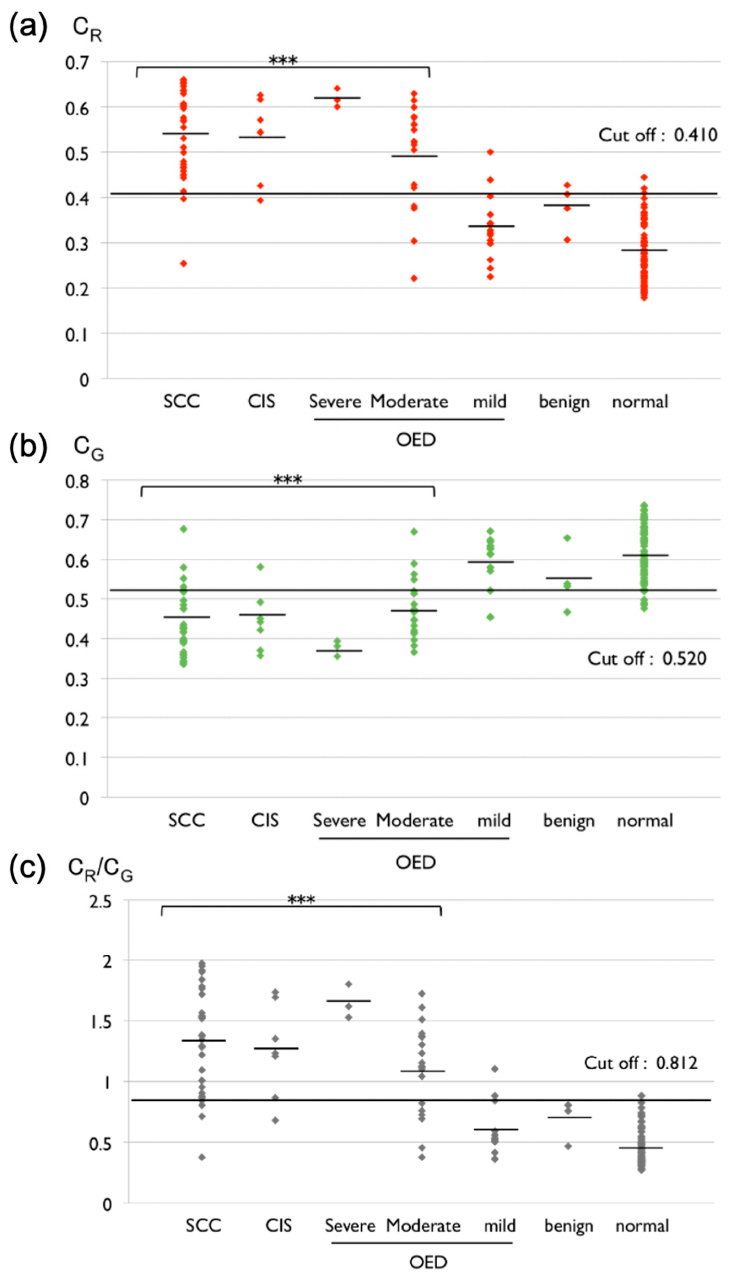
Figure 4. Scatter plots of the C R and C G and C R to C G ratio for different stages of oral lesions. ( a ) C R : chromaticity x (red). The cutoff value (0.410) indicates the borderline between OSCC, CIS, severe or moderate OED, and mild OED or benign lesions. ( b ) C G : chromaticity y (green). The cutoff value (0.520) differentiates between OSCC, CIS, severe and moderate OED, and mild OED and benign lesions. ( c ) C R /C G ; C R to C G ratio (gray). The cutoff value (0.813) separates OSCC, CIS, and severe and moderate OED from mild OED and benign lesions (*** p < 0.001; comparison between OSCC, CIS, severe and moderate OED, and mild OED and benign